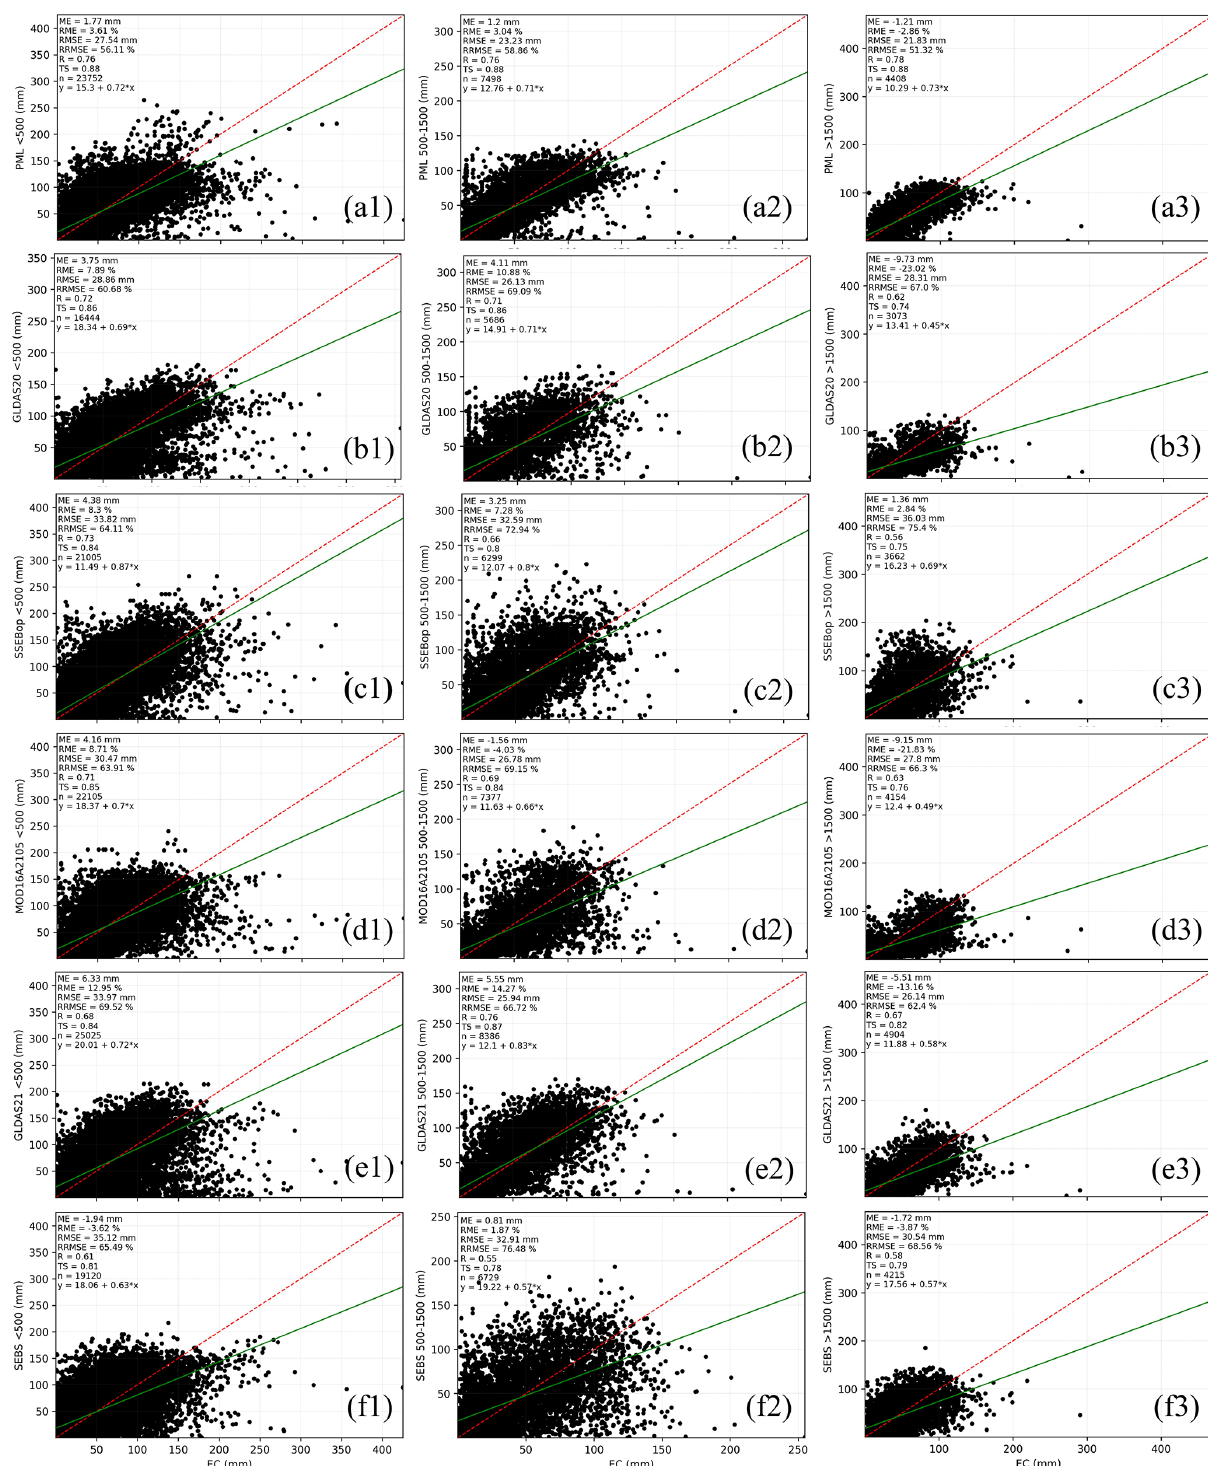
Figure 11. Monthly ET products (PML: a ; GLDAS20: b ; SSEBop: c ; MOD16A2105: d ; GLDAS21: e ; SEBS: f ) against flux EC ET aggregated for all sites for each elevation level ( < 500m: 1; 500–1500m: 2; > 1500m: 3).